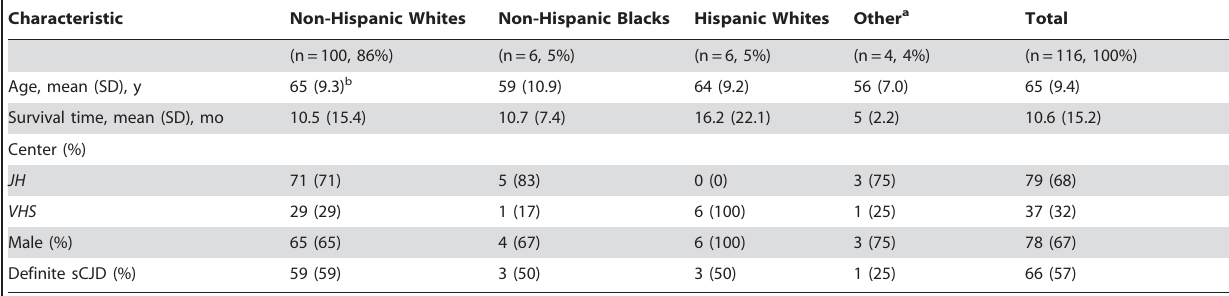
Table 1. Demographic characteristics of study